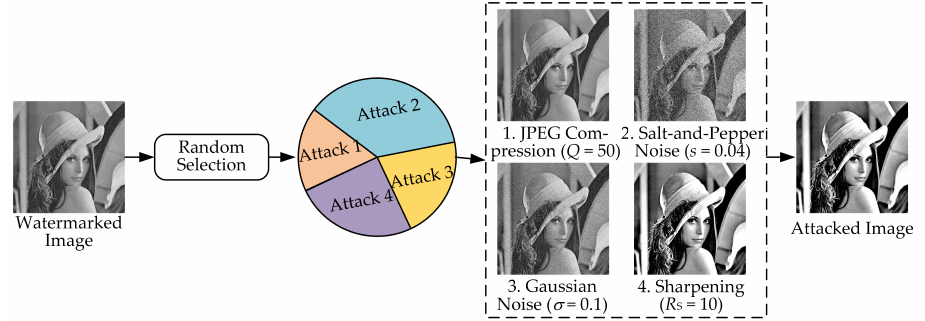
Figure 4. Attack layer: simulate four common attacks.